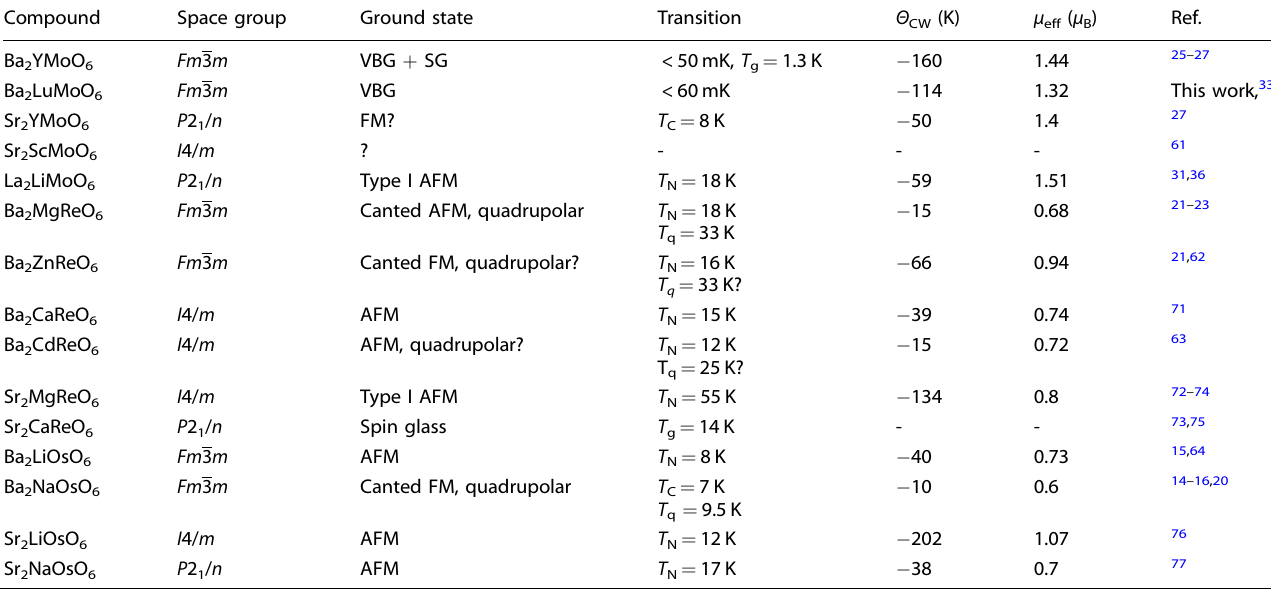
Table 1. Magnetic properties of double perovskites, where the only magnetic cation is a d 1 cation (Mo 5 + 4 d 1 , Re 6 + 5 d 1 or Os 7 + 5 d 1 ) on the B ” -site. Adapted and expanded from refs. 12,21